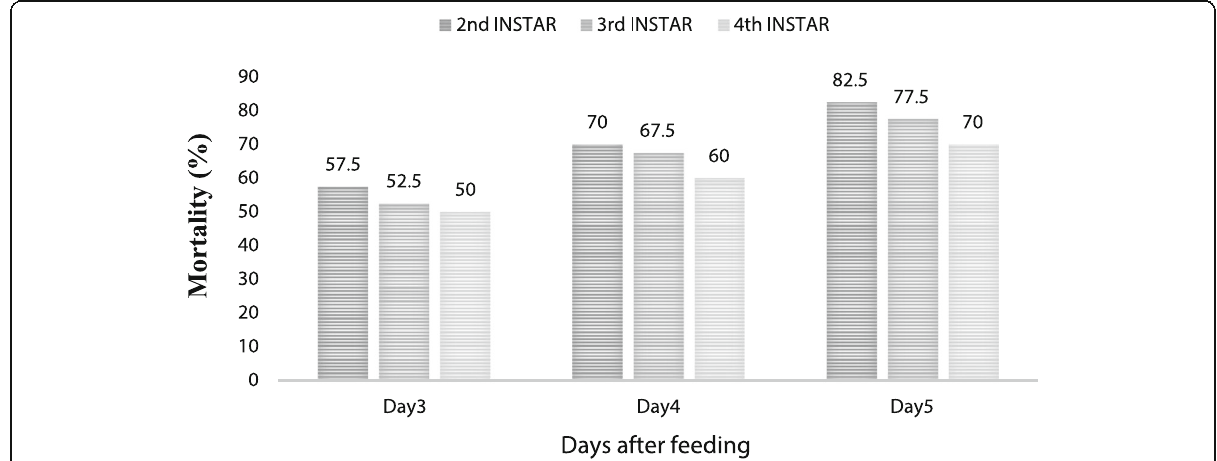
Fig. 2 Mortality of different larval instars of Tuta absoluta caused by 4D4 at LC